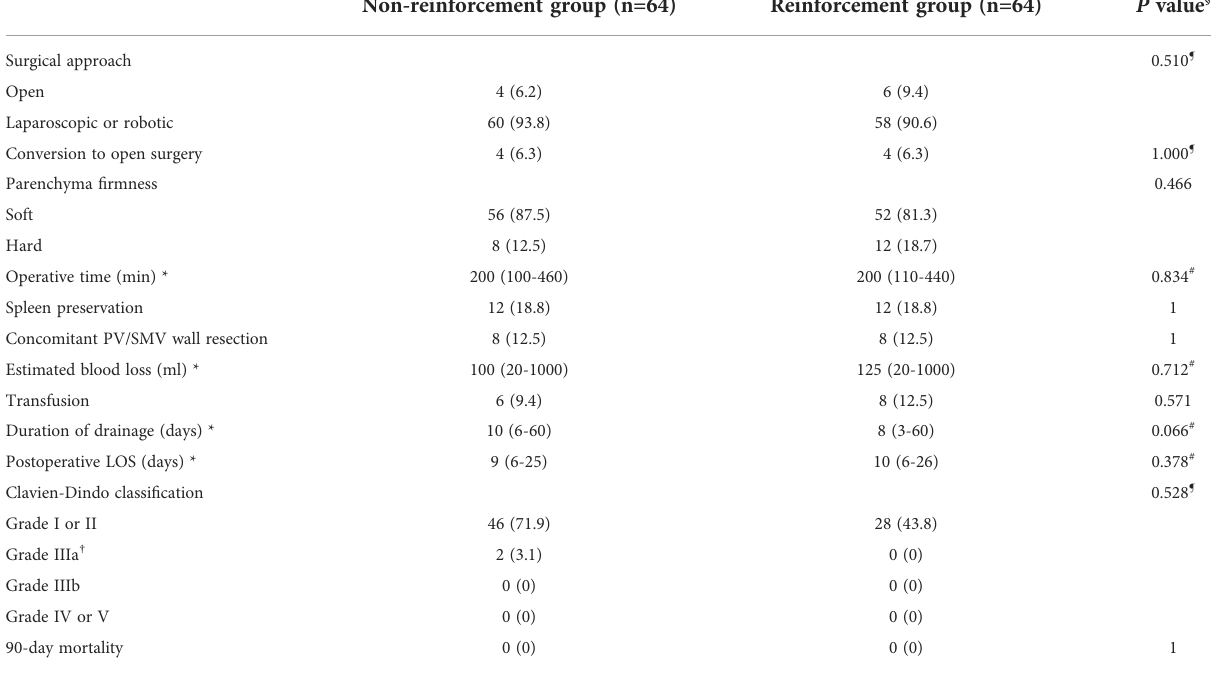
TABLE 4 Comparison of safety and ef fi ciency-related outcomes between the two groups. Non-reinforcement group